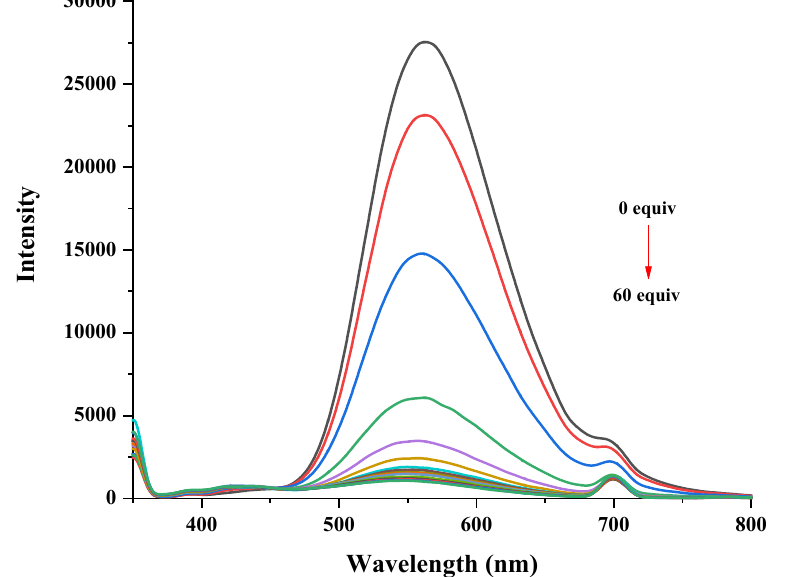
Figure 10. The fluorescence spectra in DMSO of titration between sensor R1 (5 × 10 − 5 M) and F − ion in the range of concentrations of 0-60 equivalents.